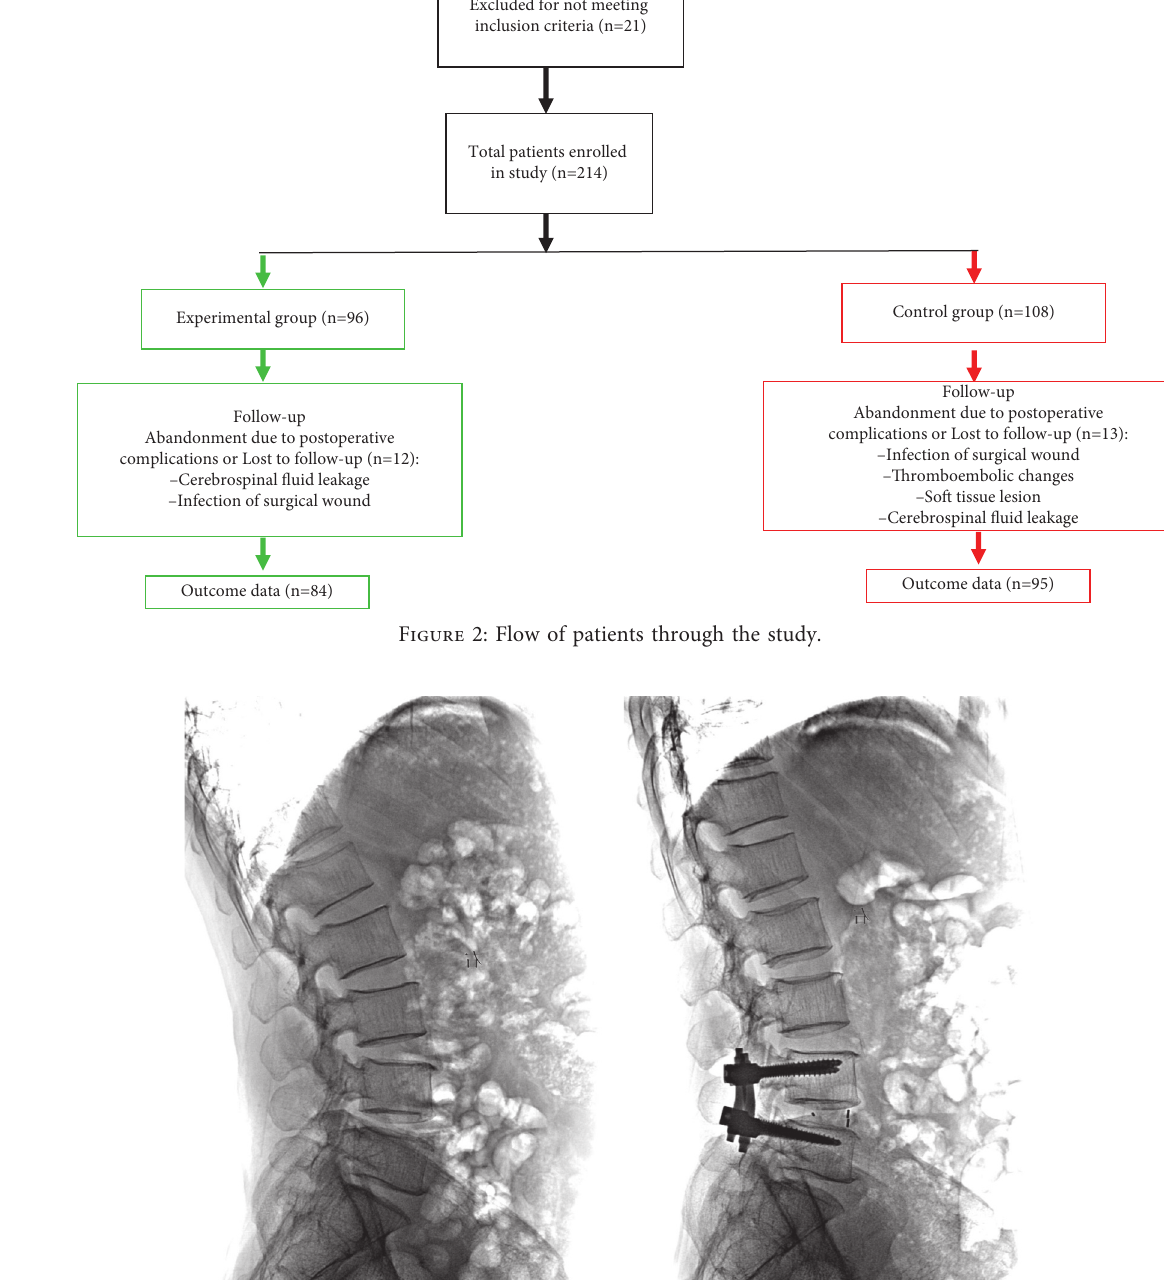
Figure 3: Representative case of a patient with an L4-5 LDH. Preoperative (a) and postoperative (b) radiographs were obtained by ERAS during the